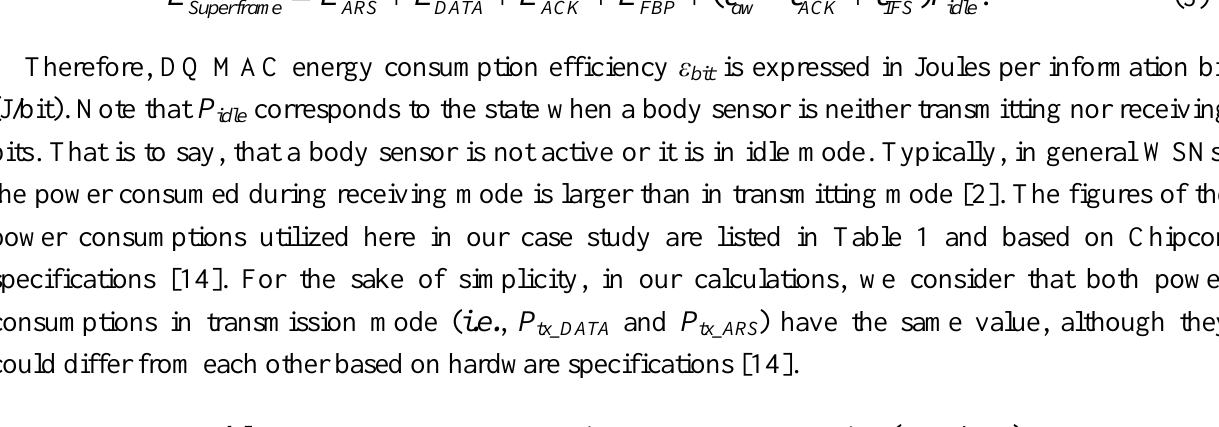
Table 1. IEEE 802.15.4 Transceiver Power Consumption (–25 dBm).